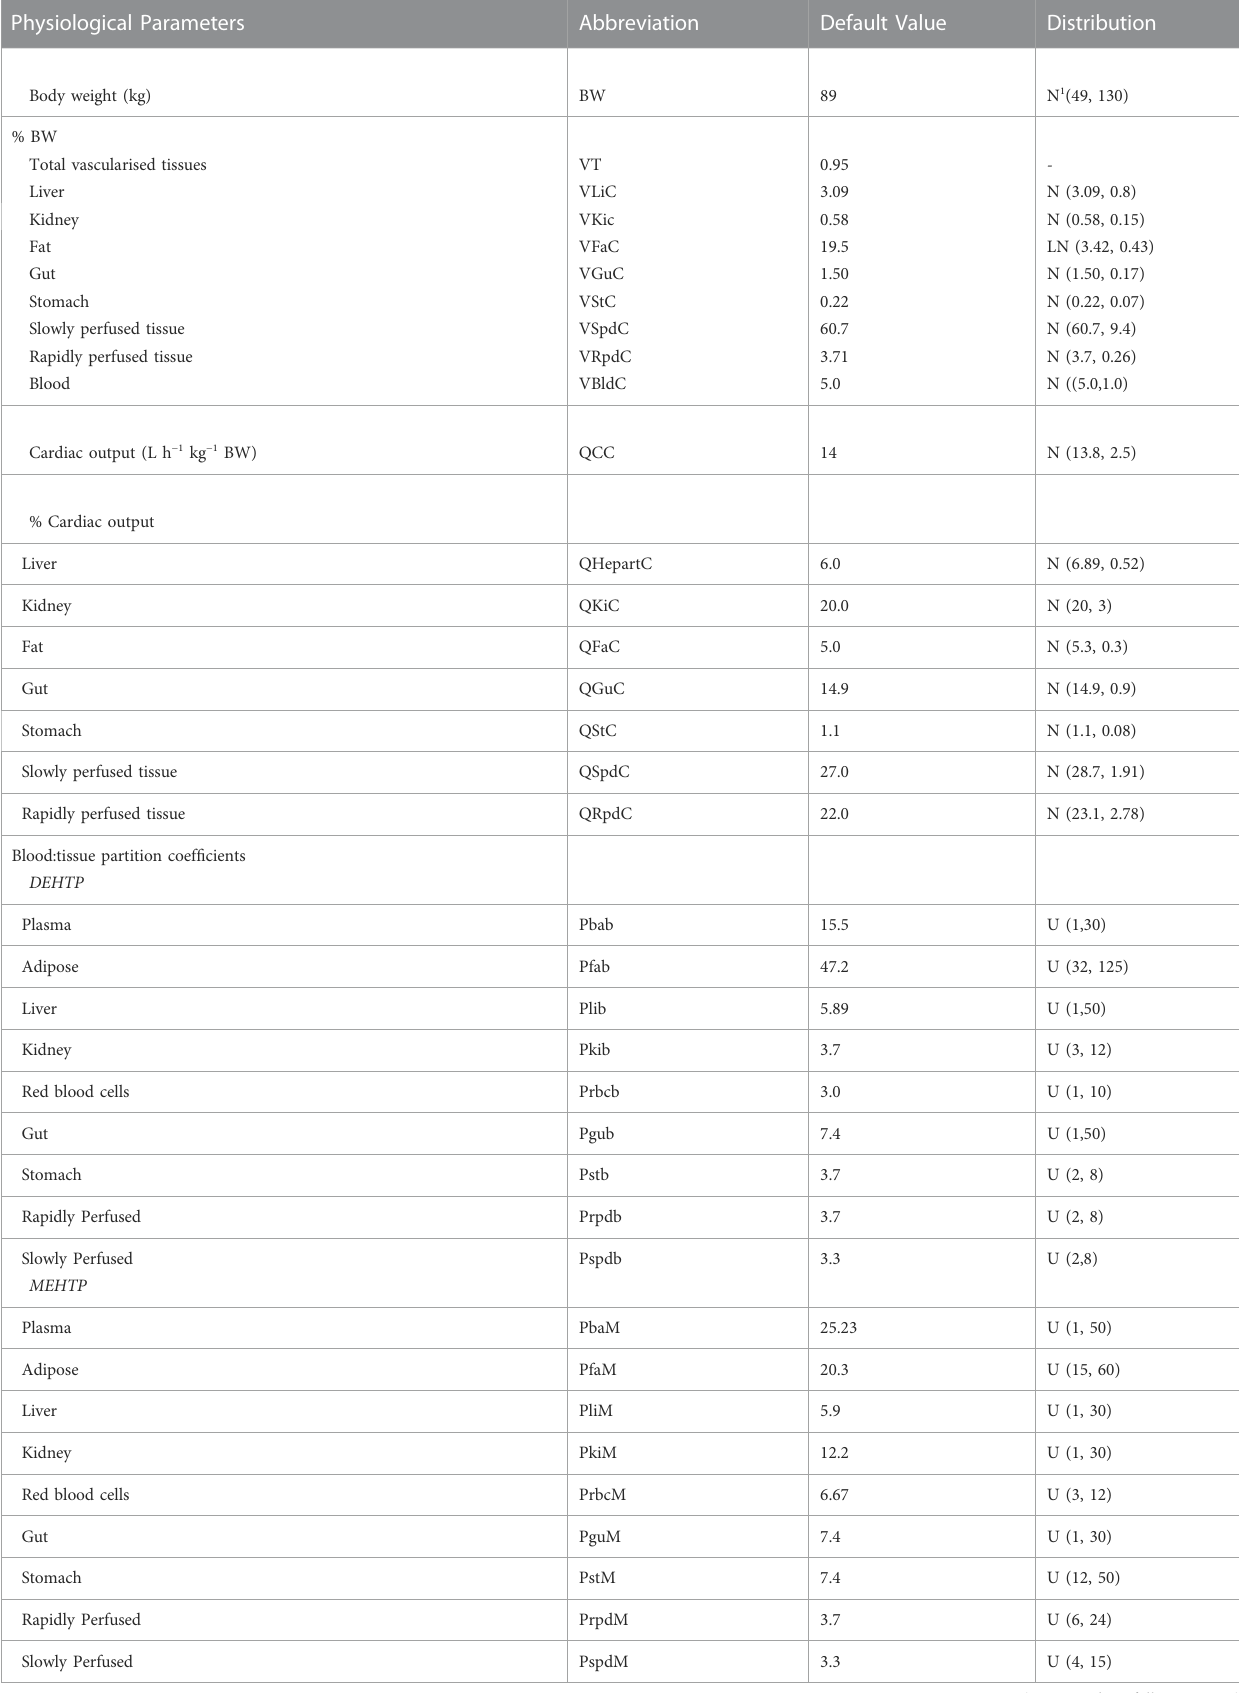
TABLE 3 Physiological and kinetic default values used in PBPK model and probability distributions applied for uncertainty and sensitivity analyses. Physiological